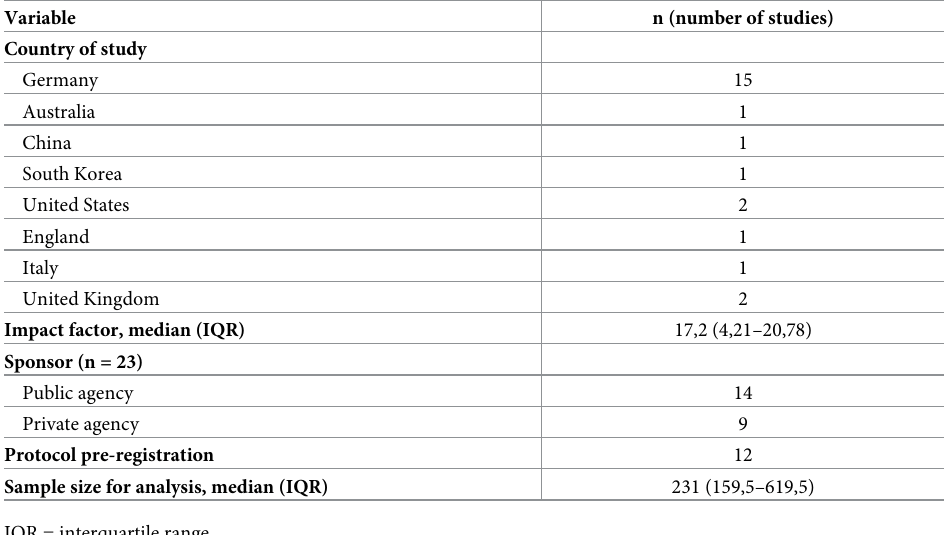
Table 1. Characteristics of included